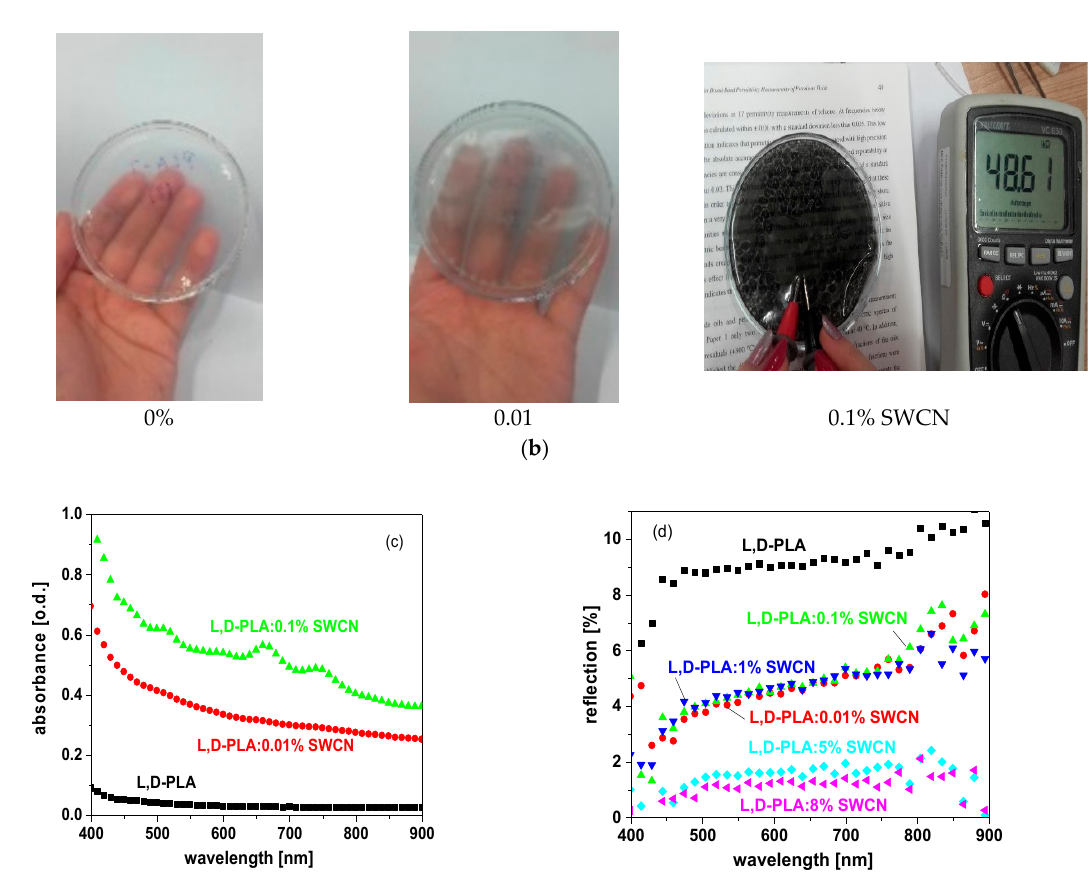
Figure 3. ( a ) Created L , D -PLA films without and with SWCN content of 0.01%, 0.1%, 1%, 5%, 8%, ( b ) translucence of L , D -PLA films without and with SWCN content of 0.01%, and 0.1%, ( c ) absorbance and ( d ) reflection UV-Vis